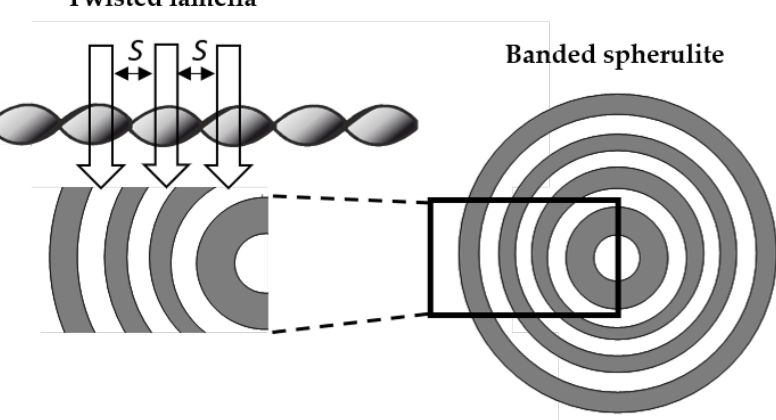
Figure 11. Scheme showing possible twisted helical chain orientation corresponding to the bright- dark rings in banded spherulites. S — band spacing.